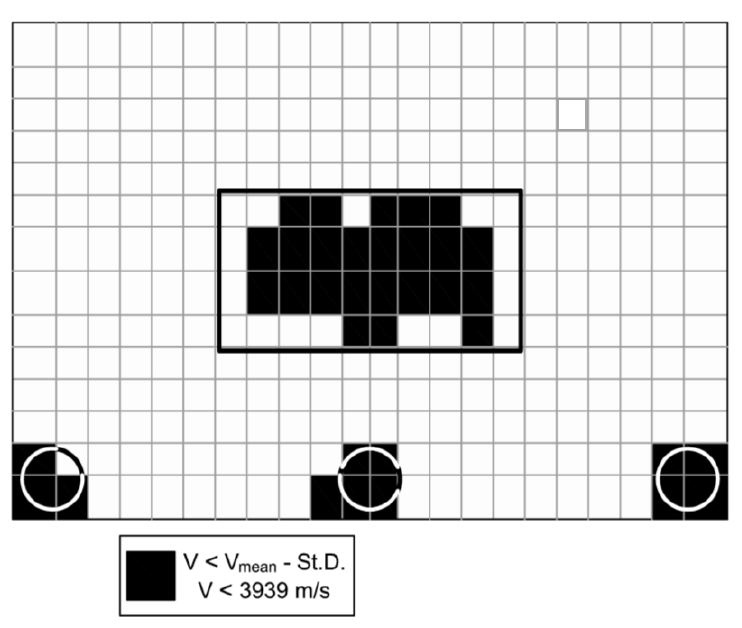
Figure 8. Map 6: Grid A. Defective areas.